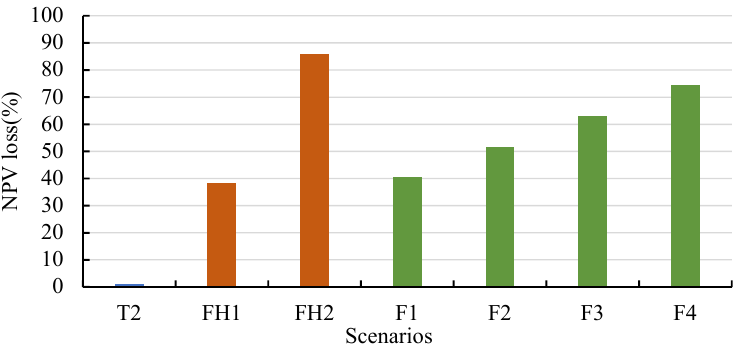
Figure 4. Net present value (NPV) loss proportion of timber production incurred in alternative management strategies for Maoershan Forest Farm, China, compared to scenario T1. The bars represent scenarios within the strategies: timber-oriented management strategy (TMS, scenario T2), fixed selection of suitable habitat management strategy (FSSHMS, scenarios FH1 and FH2), and free selection of restricted suitable habitat management strategy (FSRSHMS, scenarios F1 to F4).